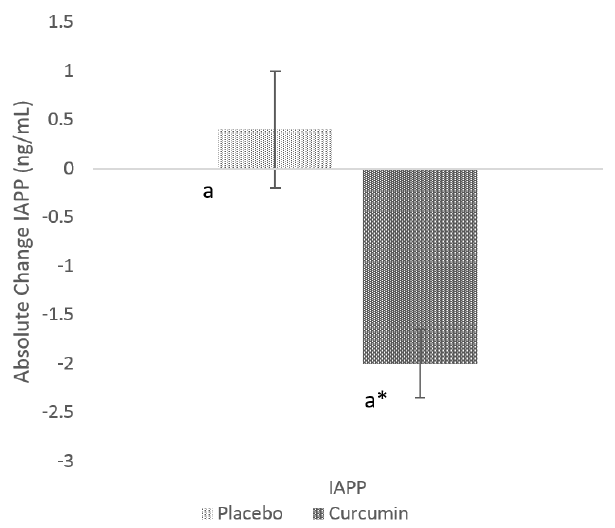
Figure 2. Absolute change in serum islet amyloid peptide (IAPP) from baseline to post-intervention in placebo and curcumin groups for 12 weeks. * p < 0.05 represents the difference within the treatment group. Small letter (a) represents the significant difference between the treatment groups.